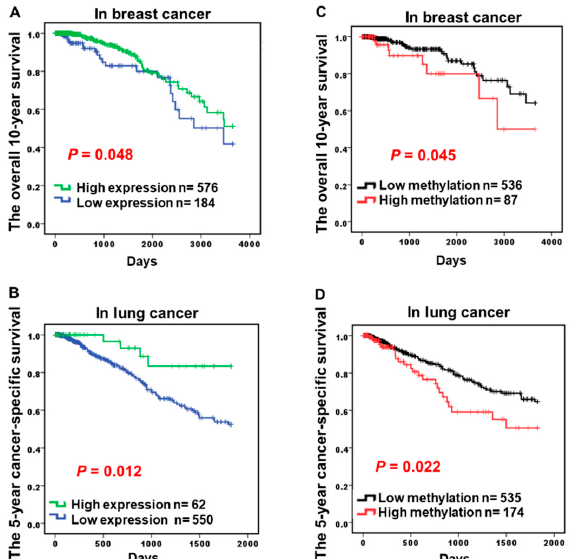
Figure 3. CCND2 promoter hypermethylation and mRNA expression level and its correlation with survival in lung, breast, and liver cancer patients Data for CCND2 DNA hypermethylation and the mRNA expression level assayed by the Illumina Methylation 450K array-based assay and RNA sequencing and survival data were collected from TCGA. ( A , B ) Kaplan-Meier survival curves were used to compare the survival between cancer patients with low and high CCND2 mRNA expression levels in breast cancer and lung cancer patients. ( C , D ) Kaplan–Meier survival curves were used to compare the survival between cancer patients with low and high CCND2 methylation levels in breast cancer and lung cancer